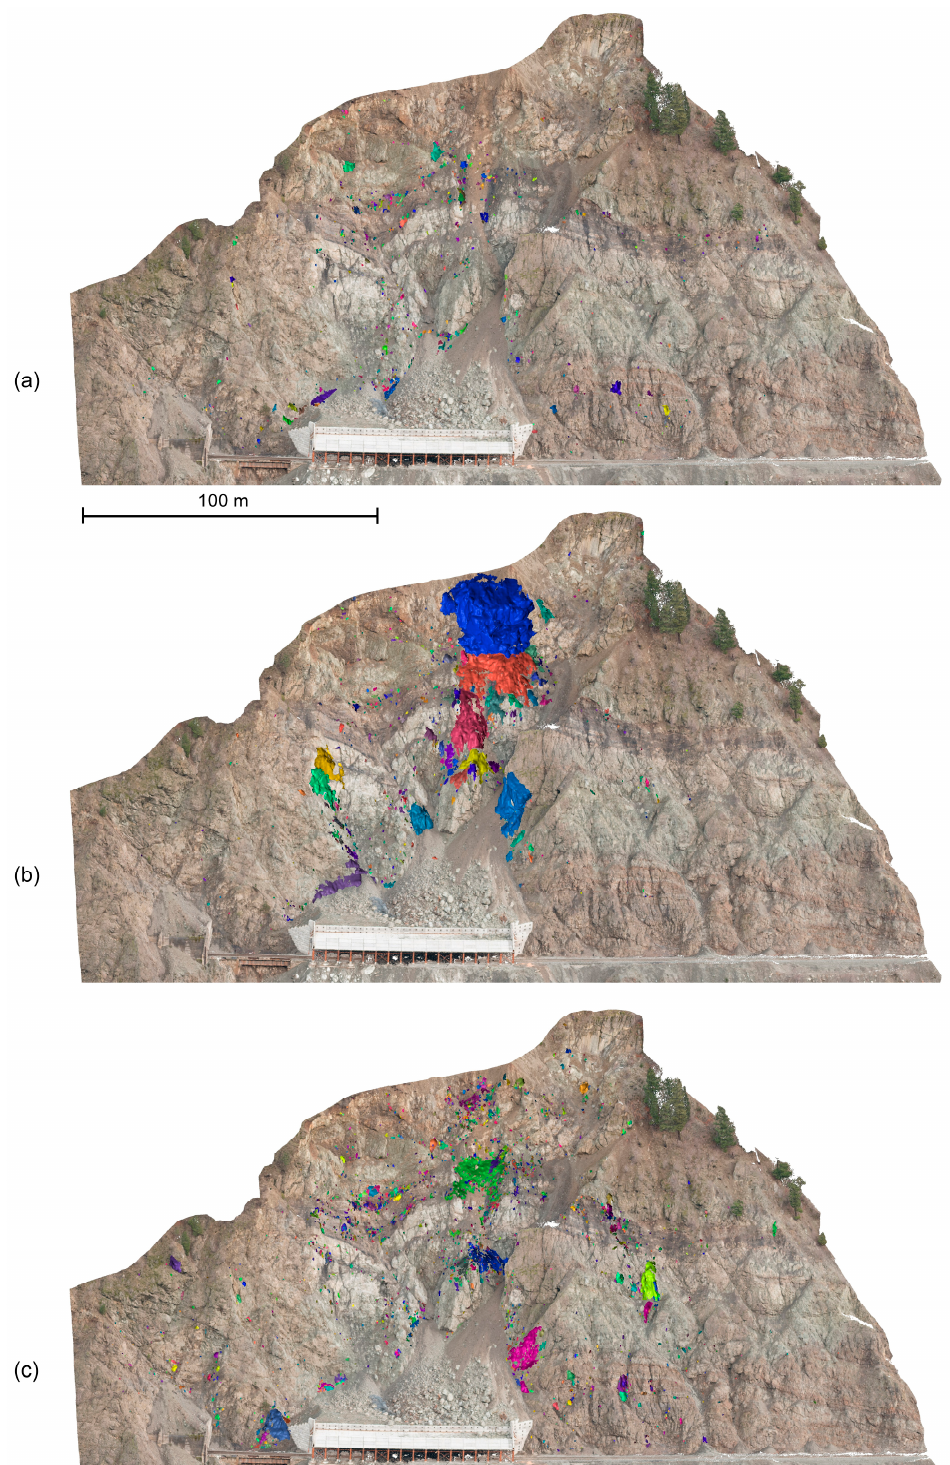
Figure 3. Rockfall data of the CN Ashcroft Mile 109.4 study site, across a 5-year span from November 2013 to December 2018. Presented in 3 different intervals to reduce overprinting data in the visualization. An 80 m long rock shed constructed in fall of 2014 supports a talus cone which has built up, allowing rockfall fragments to pass overtop of the track. Clustered rockfall point clouds are randomly colourized and projected onto a helicopter photogrammetry point cloud (December 2014); ( a ) 347 days, from 28 November 2013 to 10 November 2014; ( b ) 104 days, from 10 November 2014 to 17 February 2015, occurrence of an approximate 3000 m 3 rockfall and several other events in the hundreds of cubic meters; ( c ) 1381 days, from 17 February 2015 to 4 December